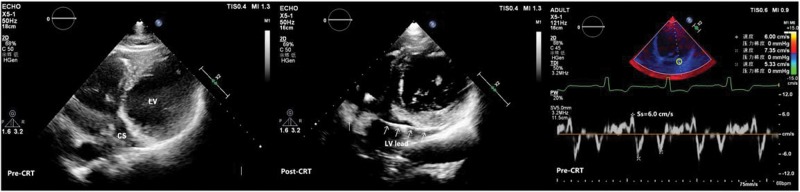
Example of myocardial velocity curve via tissue Doppler imaging. The sample was obtained from the left ventricular lead-implanted segment (yellow circle); the Y-axis represents myocardial velocity (cm/s), and the X-axis represents time; Ss is the positive peak on the curve.